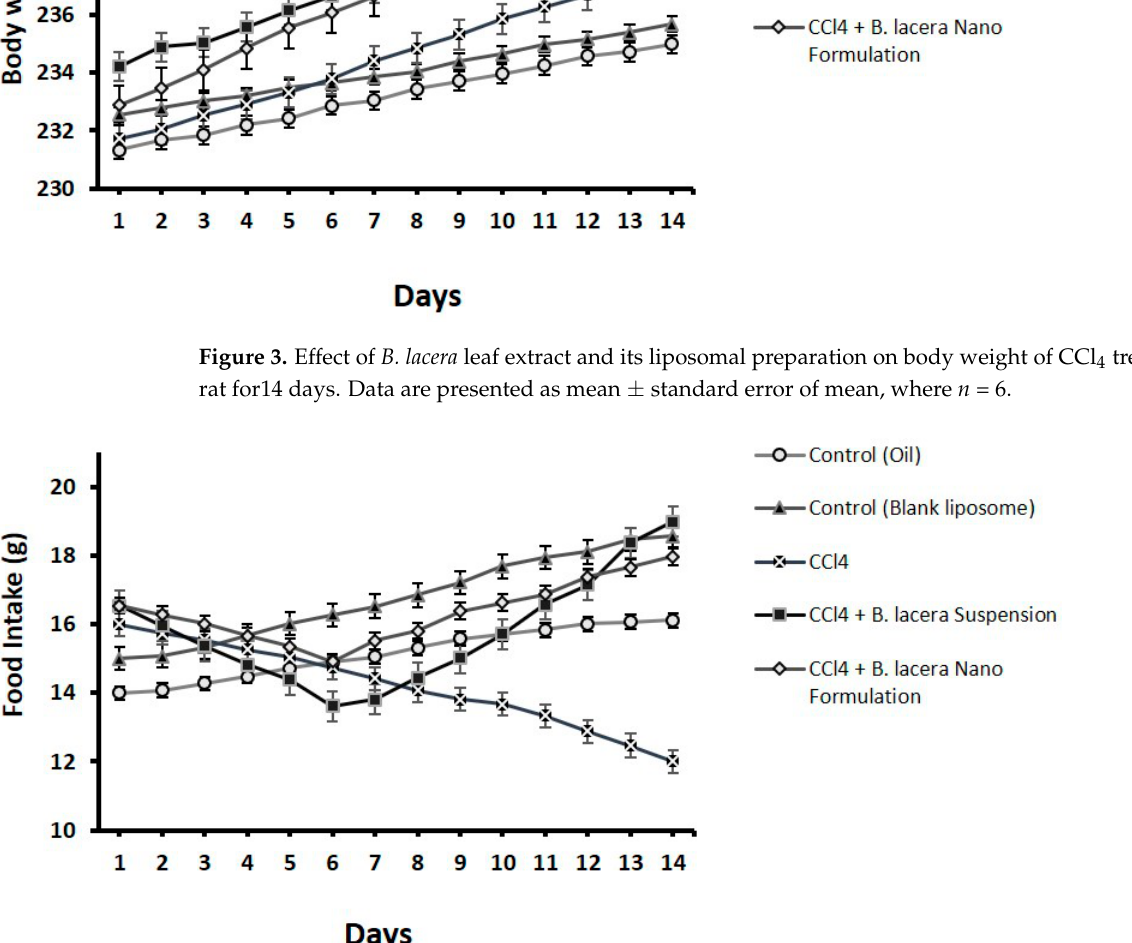
Figure 5. Effect of B. lacera leaf extract and its liposomal preparation on water intake of CCl 4 ‐ treated rats for14 days. Data are presented as mean ± standard error of mean, where n = 6. 3.4. Effect of B. lacera Leaf Extract and i Liposomal Preparation on Different Organ Wet Weights B. lacera showed marked effects on the CCl 4 ‐ treated rat’s organ weights observed from the wet weight of the organs (Table 4). CCl 4 ‐ treated rats showed a reduction in wet weight of the liver compared to control group rats. Results showed that Long Evan rats treated with the liposomal preparation of B. lacera leaf extract improve liver wet weight more compared to rat groups treated with B. lacera suspension. However, the weights of brain, heart, and lung were not improved markedly for CCl 4 ‐ intoxicated rat groups